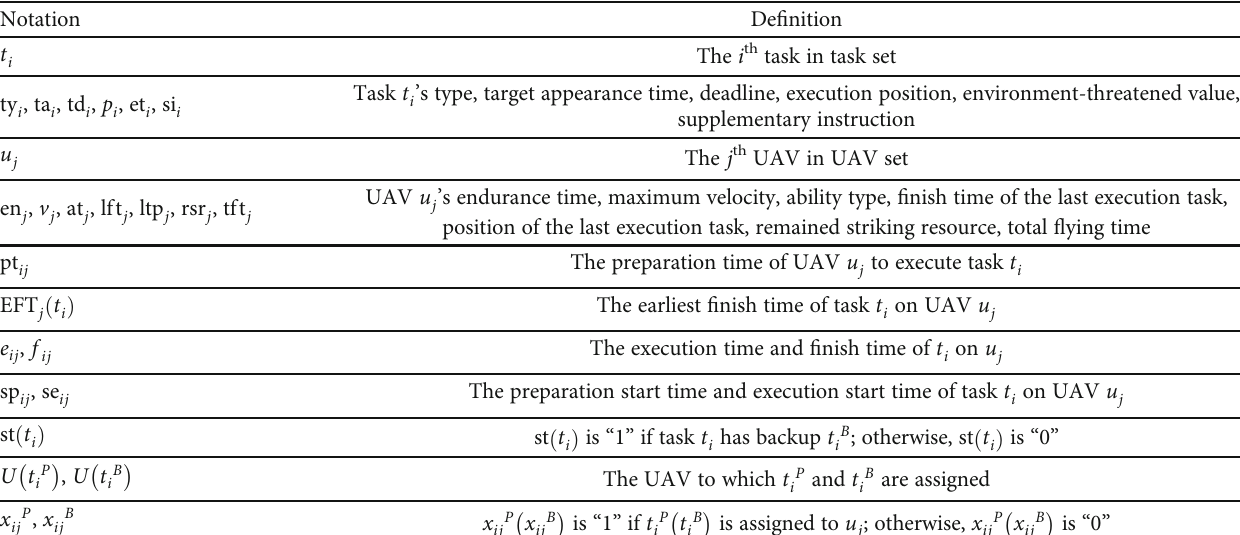
Table 1: De fi nition of main